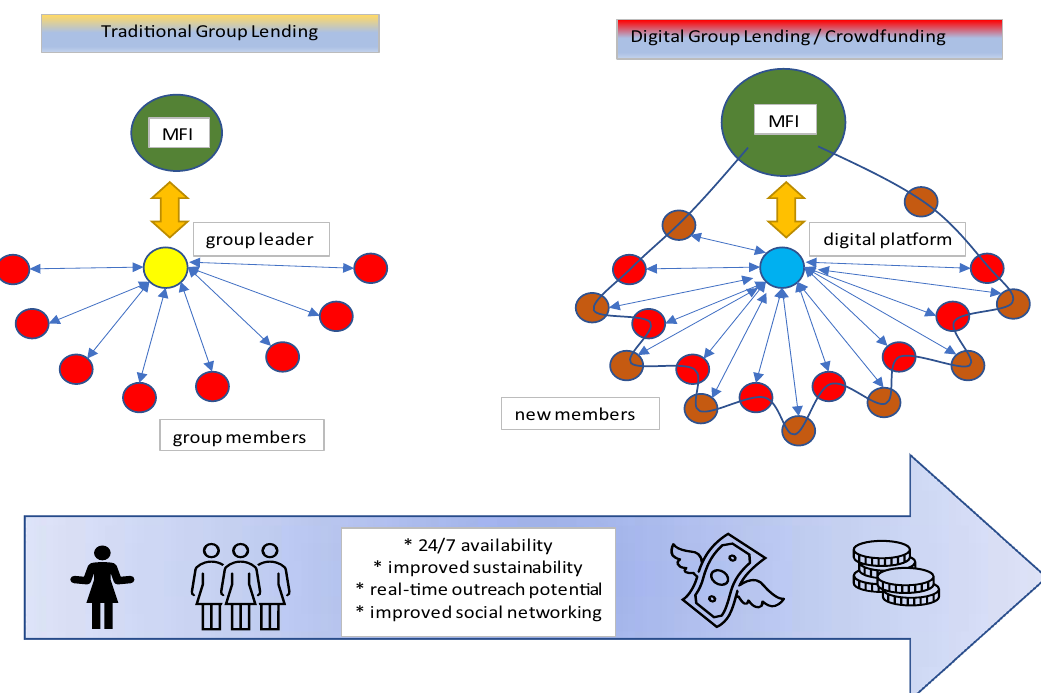
Fig. 2 Traditional versus digital group lending and crowdfunding. It shows thedifference between these two social networks. In a digital group lending, the group leader has been replaced by a digital platform which exhibits the advantages listed below. Source: Own